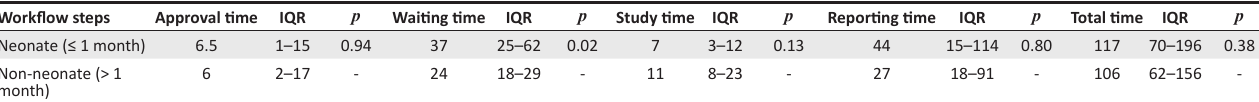
TABLE 3: Patient parameters. Workflow